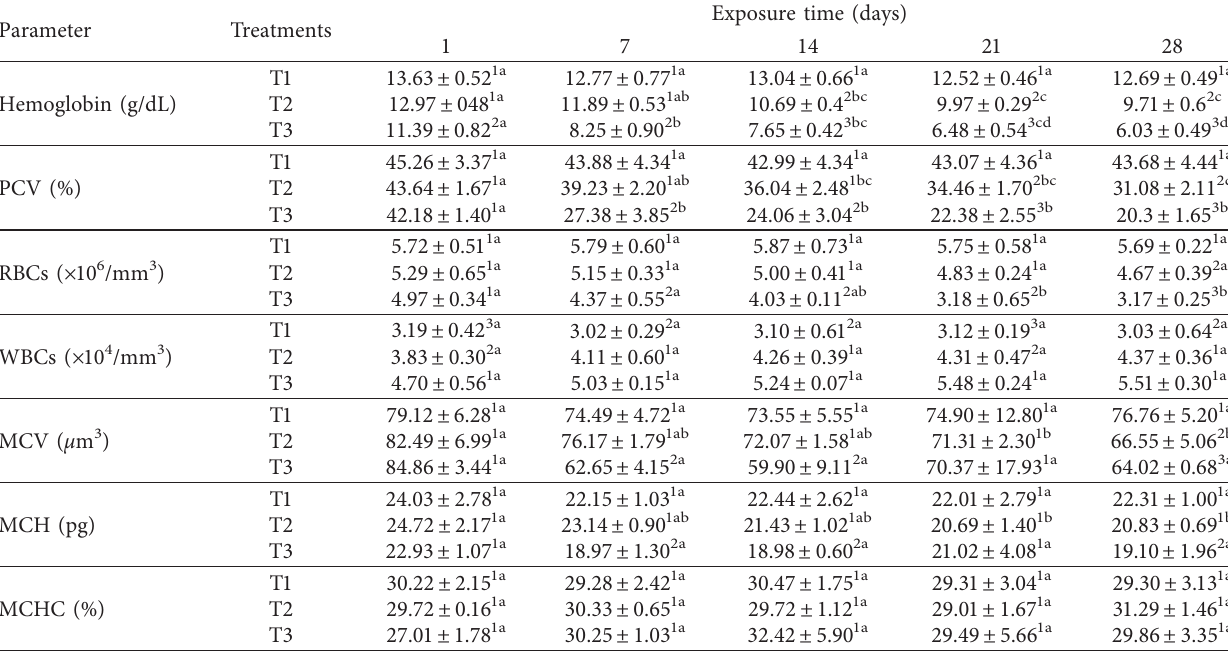
Table 1: Effects of sublethal exposure of malathion on hematology (mean ± SD) at different time intervals in B. gonionotus . Parameter